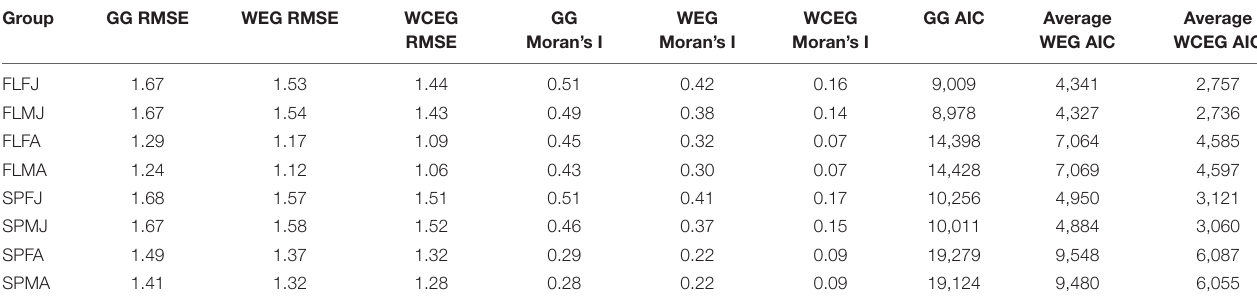
TABLE 3 | RMSE, Moran’s I, and AIC values for each model and group type. Group